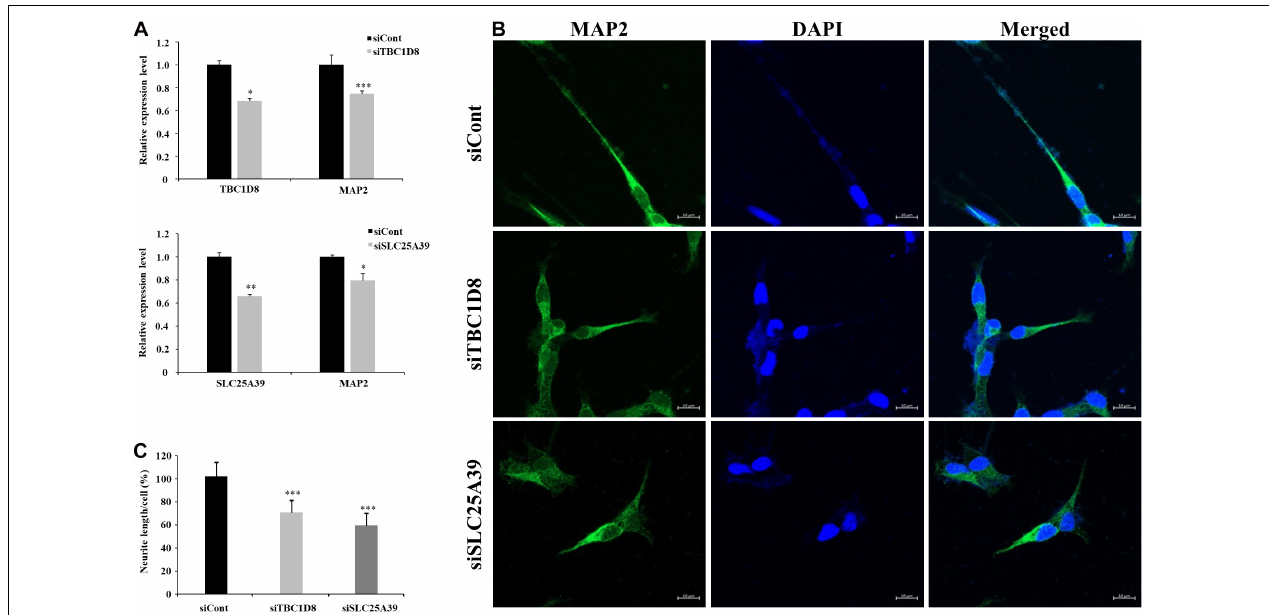
FIGURE 5 | Neurite length analysis by knockdown of candidate genes in neuronal cells. Human SH-SY5Y neuroblastoma cells were transfected with siRNA for TBC1D8 and SLC25A39 on day 3 in vitro (DIV 3). MAP2 was used as a neuronal marker. (A) Expression levels of TBC1D8 , SLC25A39 , and MAP2 were analyzed by RT-PCR ( n = 3). (B) After retinoic acid stimulation for 48 h, the cells were stained for MAP2 (green) and nuclei (blue). Scale bars: 30 µ m. (C) Neurite length was measured in more than 10 cells in three independent experiments. ∗ p < 0.05, ∗∗ p < 0.01, ∗∗∗ p < 0.001, and Student’s t -test compared with the control